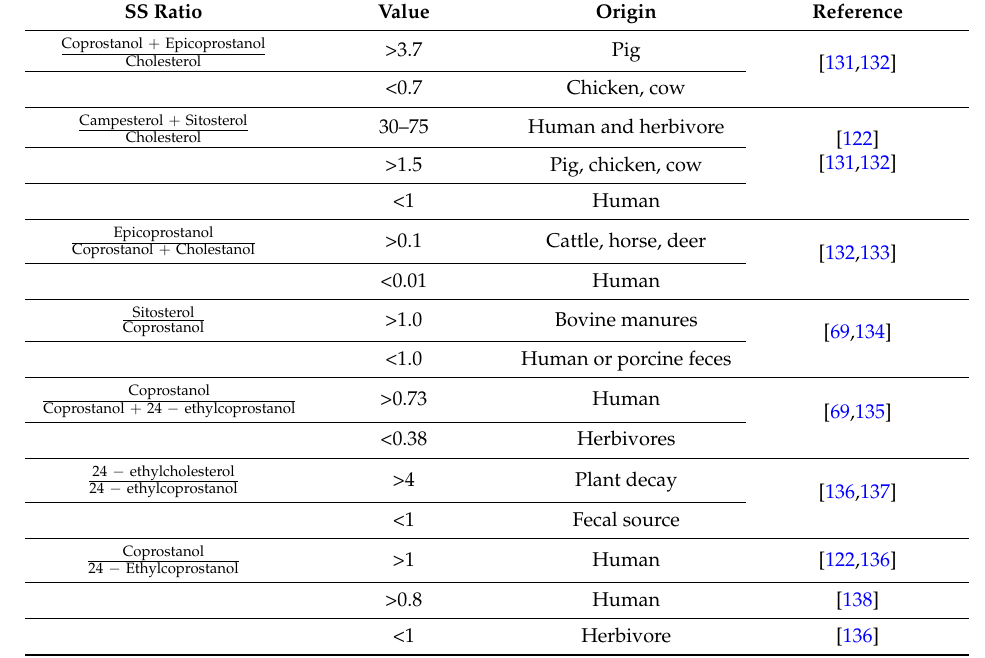
Table 3. Ratio of SSs for source